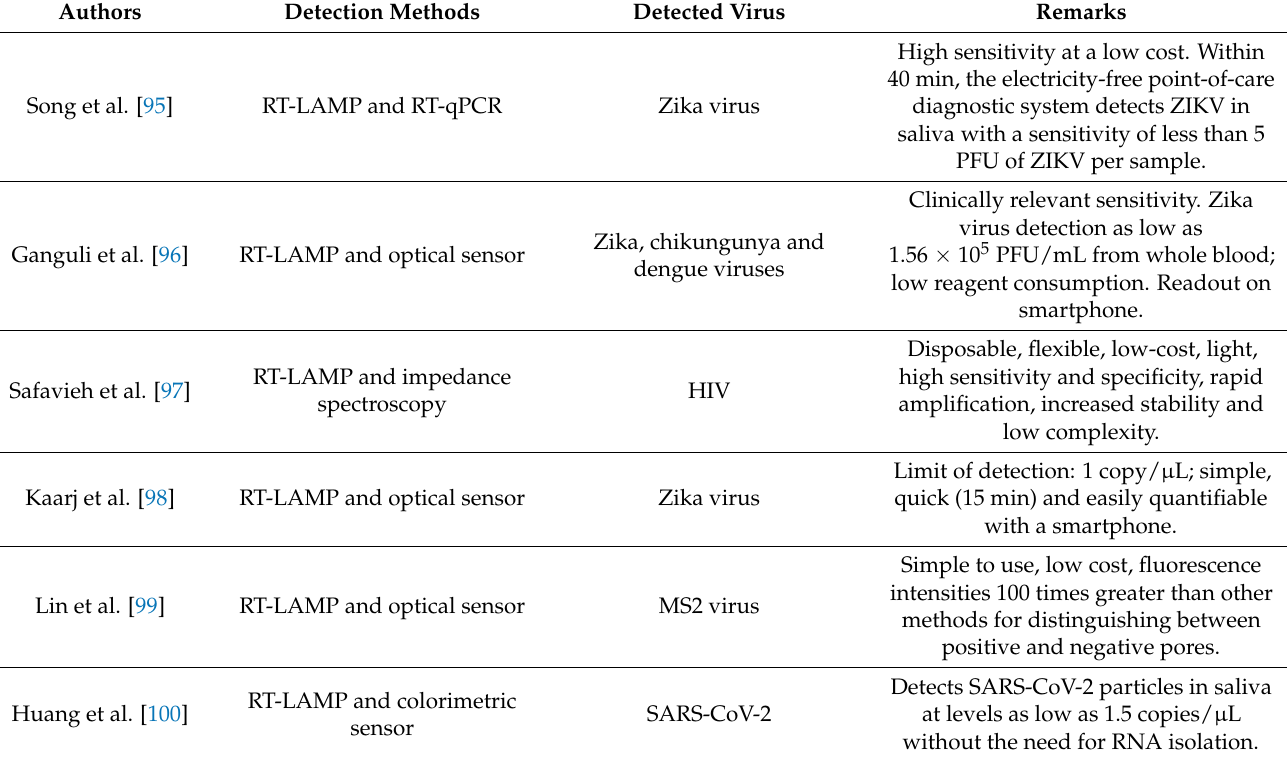
Table 4. Summary of LAMP methods used in microfluidic